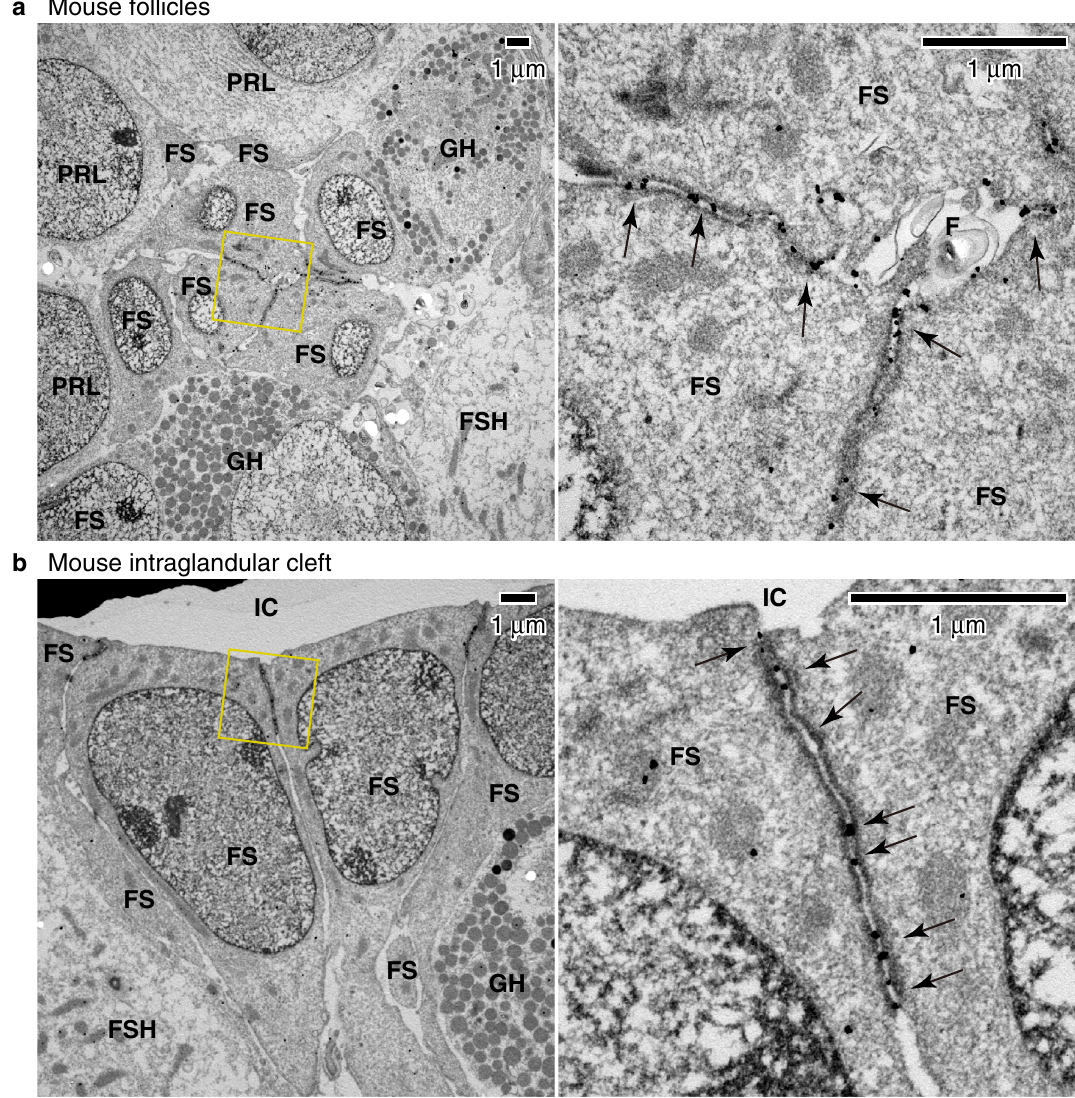
Figure 4. Claudin-9 is localized at the TJs of FS cells. ( a , b ) Immunoelectron microscopy of the adult mouse anterior pituitary gland. Claudin-9 signal was detected at TJs (arrows) between the FS cells (FS) in the follicles (F) ( a ) and the intraglandular cleft (IC) ( b ). FSH, FSH cells; PRL, PRL cells; GH, GH